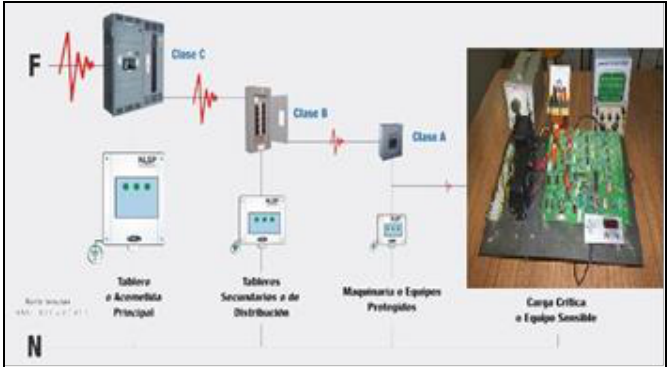
Figura 15: Esquema de conexión de los supresores contra transitorios, para protegen la tecnología. Fuente: Los Autores,